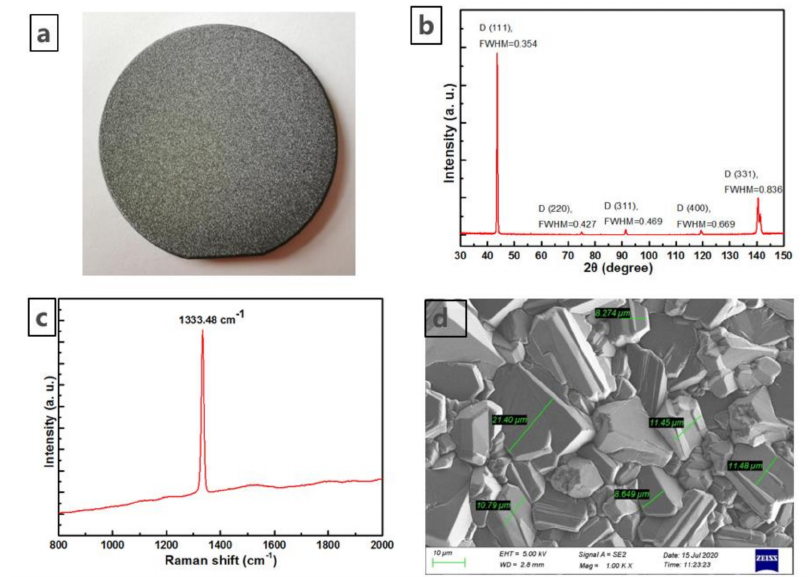
Figure 1. ( a ) Photo of as-grown diamond surface; ( b ) XRD spectra taken on as-grown surface; ( c ) Raman spectra taken on as-grown surface; ( d ) SEM micrographs of as-grown